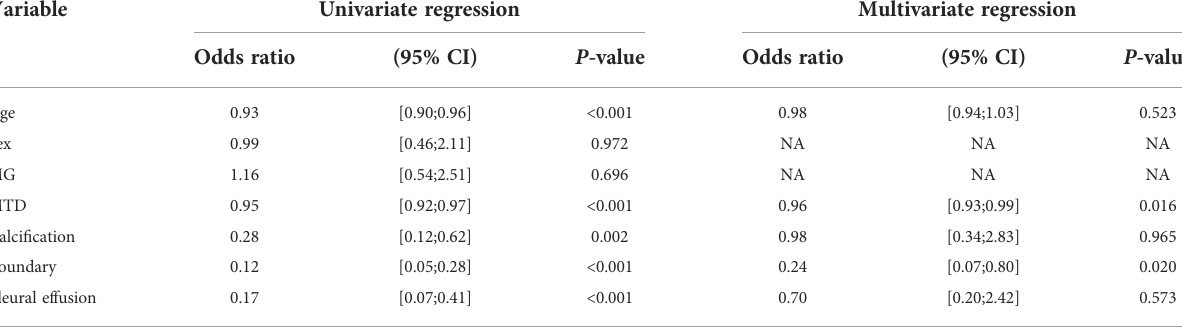
TABLE 2 Results of univariate and multivariate logistic regression for predicting the risk categorization of thymomas.